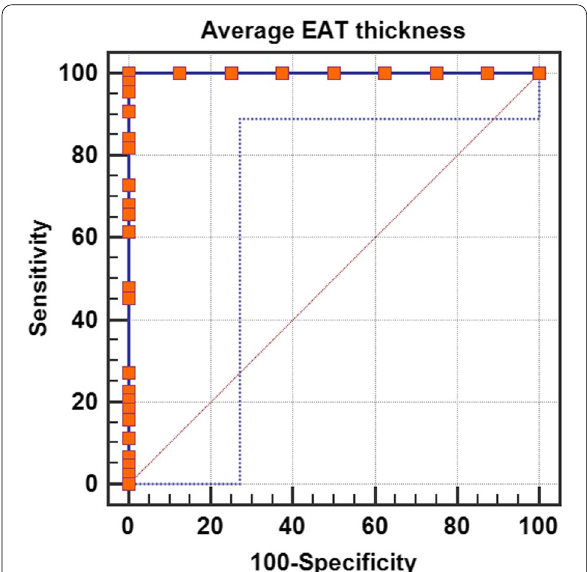
Fig. 1 The ROC (receiver operating characteristic) curve for the best cutoff value of epicardial fat volume to predict significant coronary stenosis